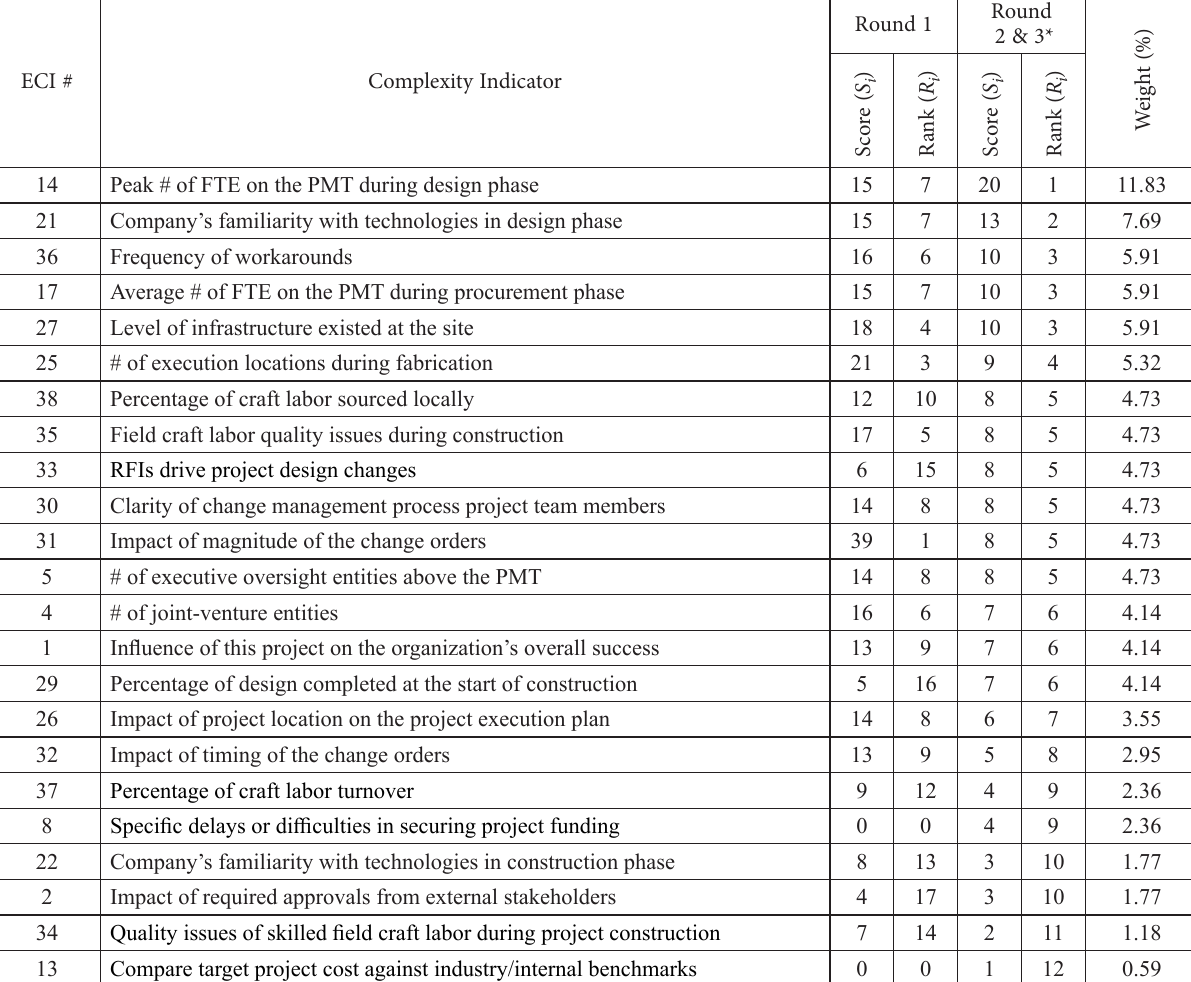
Table 5. Identified complexity indicators corresponding to consultant’s perspective, ranking, and weighting of them